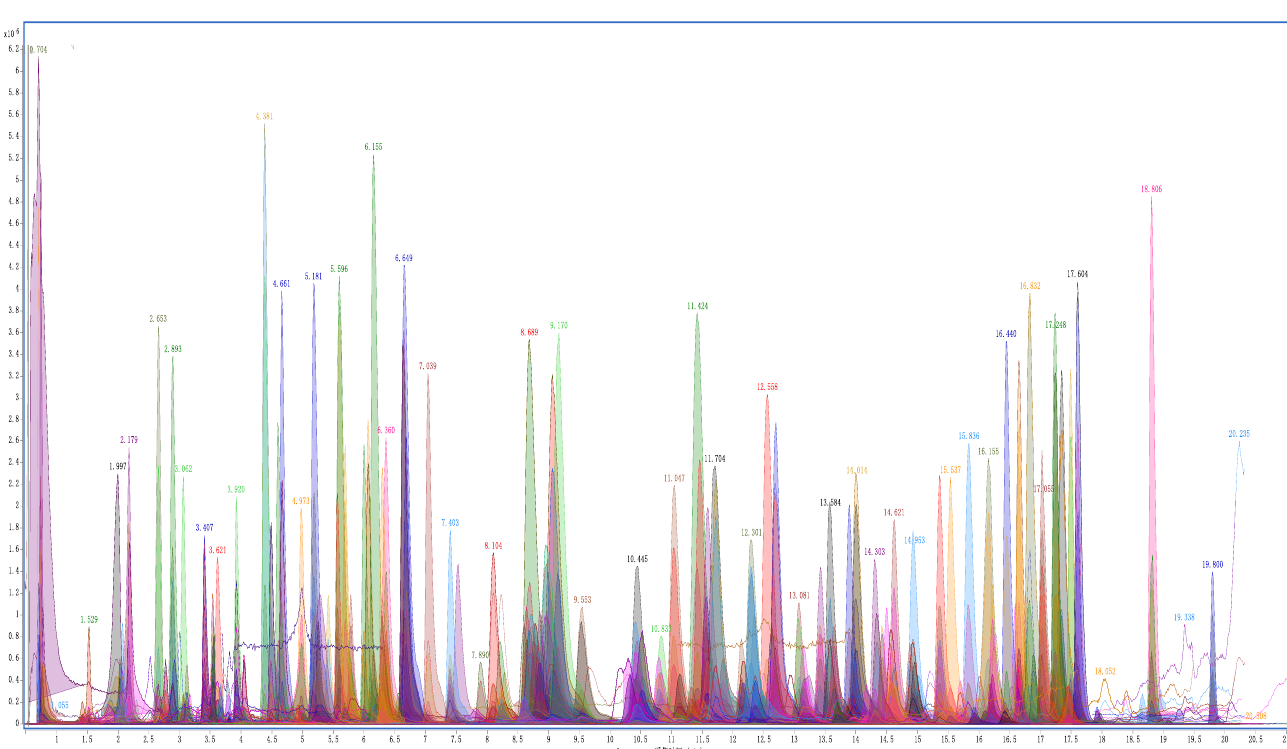
Figure 7. Overlay extraction ion chromatograms of LC-Q TOF/MS of cottonseed hull sample at spiking level of 200 μ g/kg.